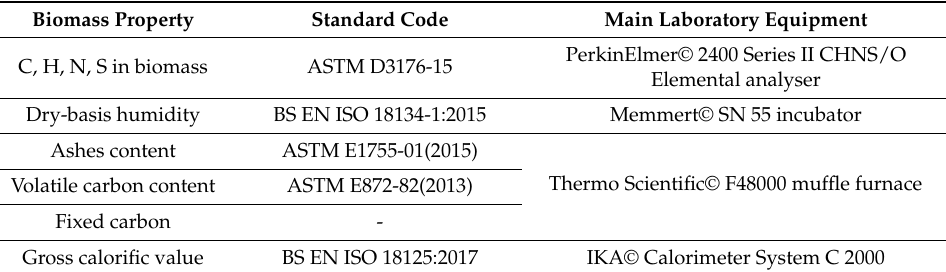
Table 4. Laboratory equipment required for biomass tests.